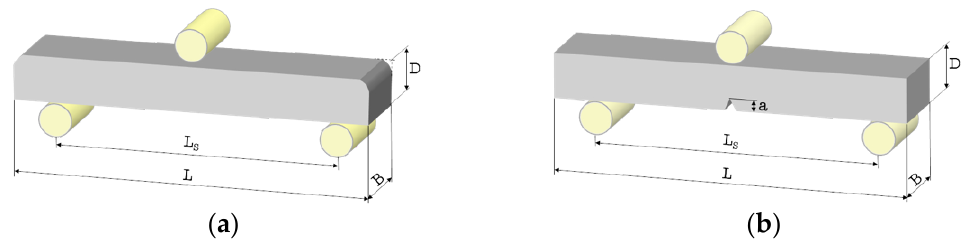
Figure 3. Three-point bending (TPB) device and ( a ) the smooth beam specimen for flexural strength measurements and ( b ) the SELNB specimen for fracture toughness measurements. L = 17 mm is the nominal sample length, B = 1.5 mm the sample width, D = 1.5 mm the sample height, L s = 12 mm the load span and “a” the notch length, which was measured for each specimen.